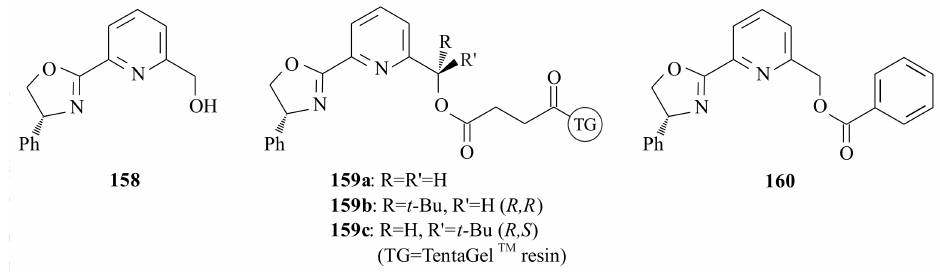
Figure 34. Unsupported and polymer-supported chiral pyridinooxazoline